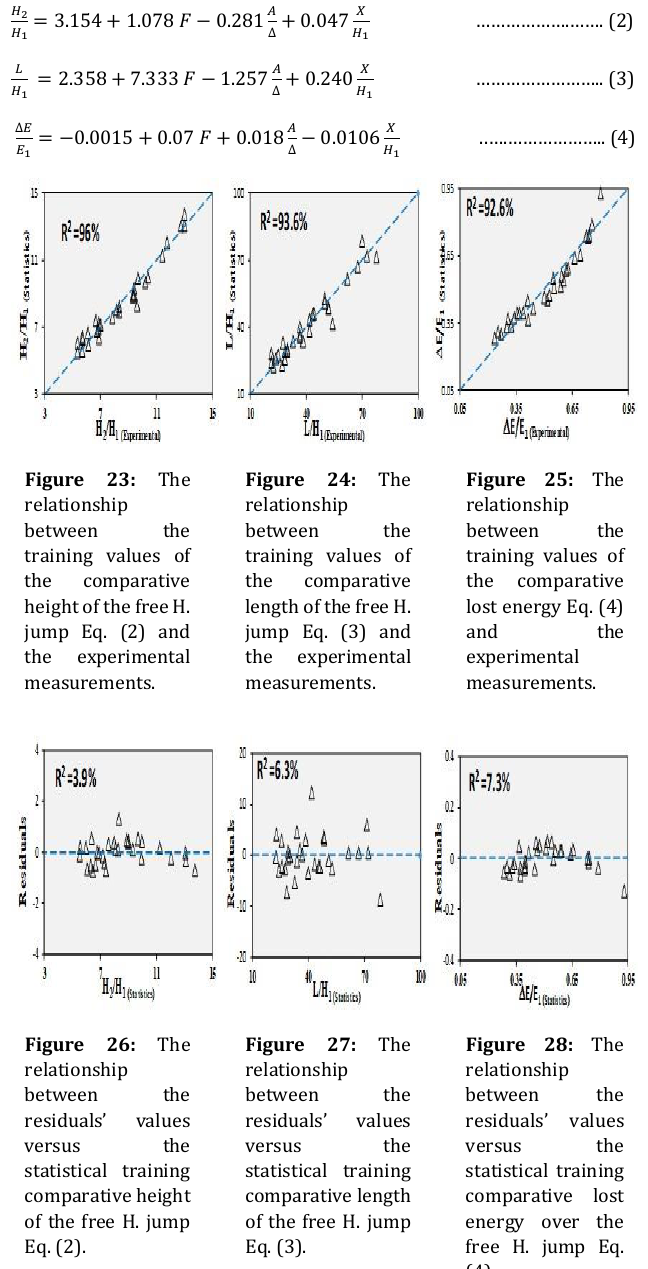
Figure 20: The Figure 21: The relationship relationship 𝐻 2 and 𝐻 1